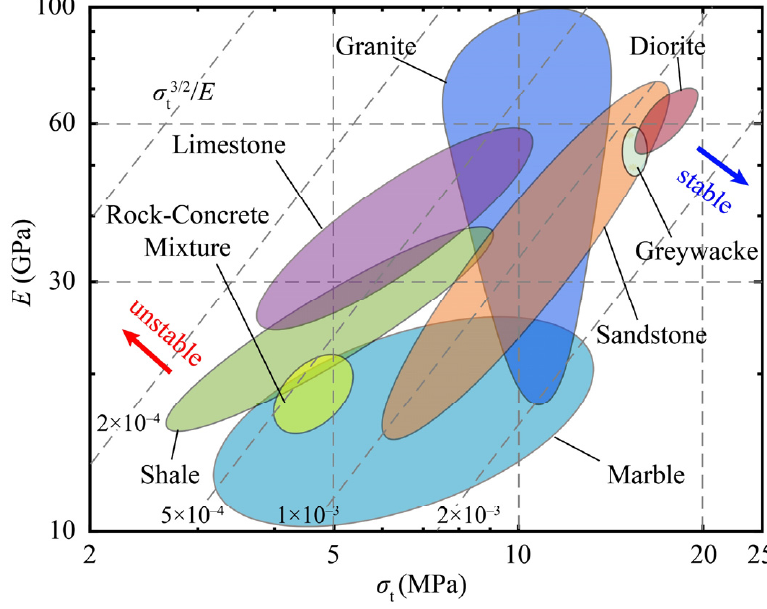
Figure 2. Stability of rocks for coal roof.